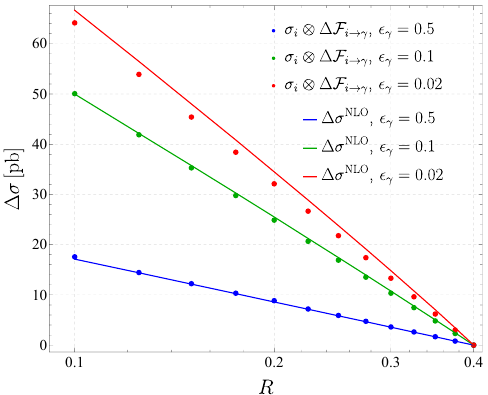
Figure 7 . Radius dependence for fixed-cone isolation for different (cid:15) γ with R ref = 0 . 4 . The lines show the full NLO cross sections, the dots correspond the the result obtained using the cone fragmentation functions. In contrast to the smooth-cone result shown in figure 4, the result depends on (cid:15) γ .